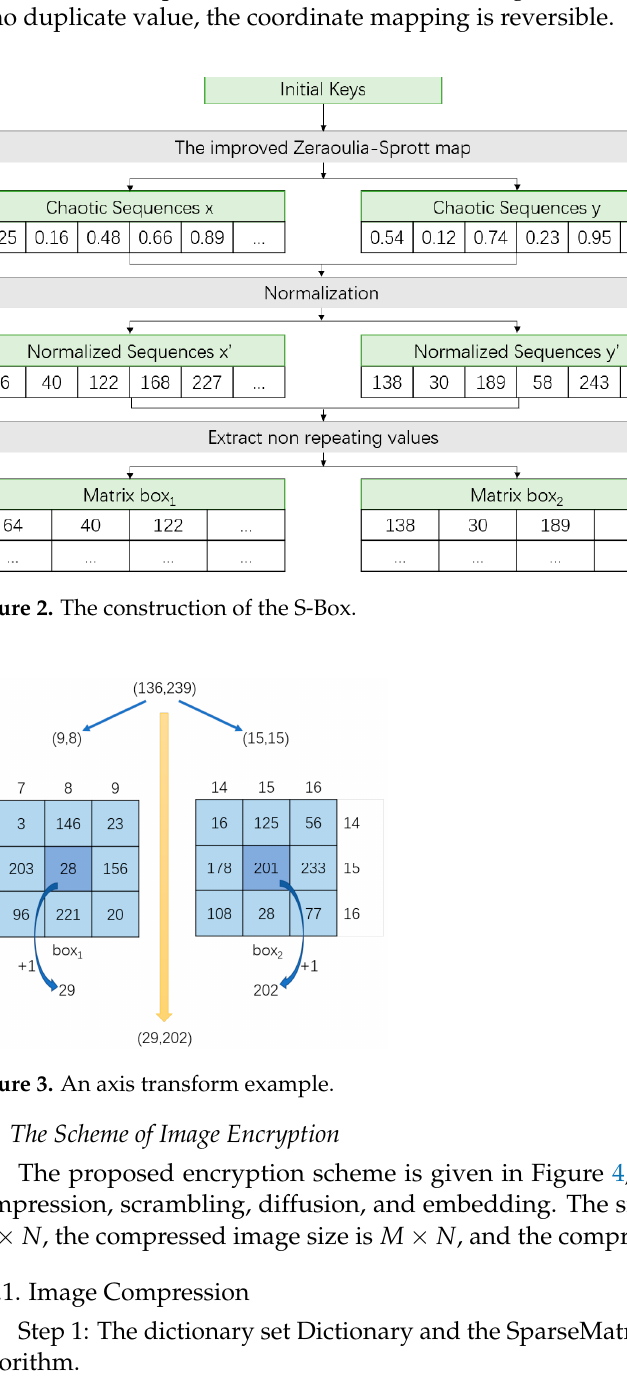
Figure 3. An axis transform example.